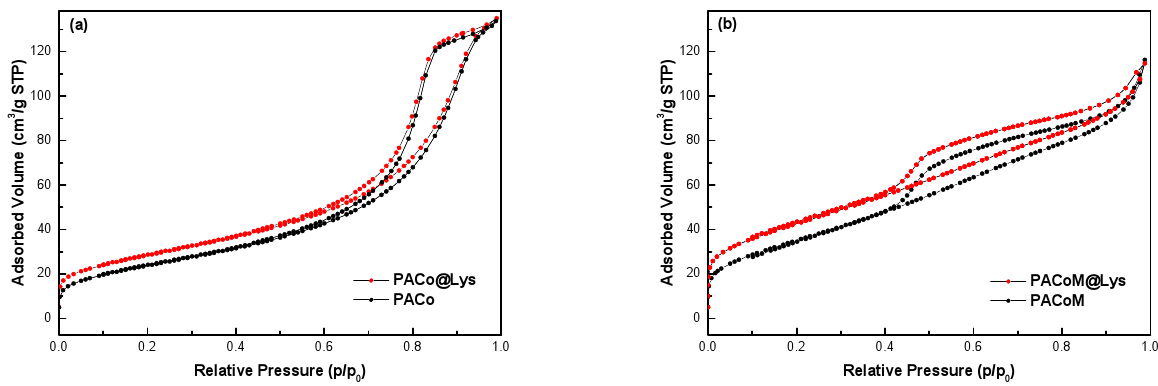
Figure 6. Zeta potential of the nanoparticles as a function of pH for ( a ) PACo–Lys and PACo sam- ples, and ( b ) PACoM and PACoM–Lys samples. Figure 7 exhibits the N 2 adsorption–desorption isotherm curves for the PACo–Lys and PACo samples (Figure 7a), and the PACoM and PACoM–Lys samples (Figure 7b). The calculated S BET values are collected in Table 1.